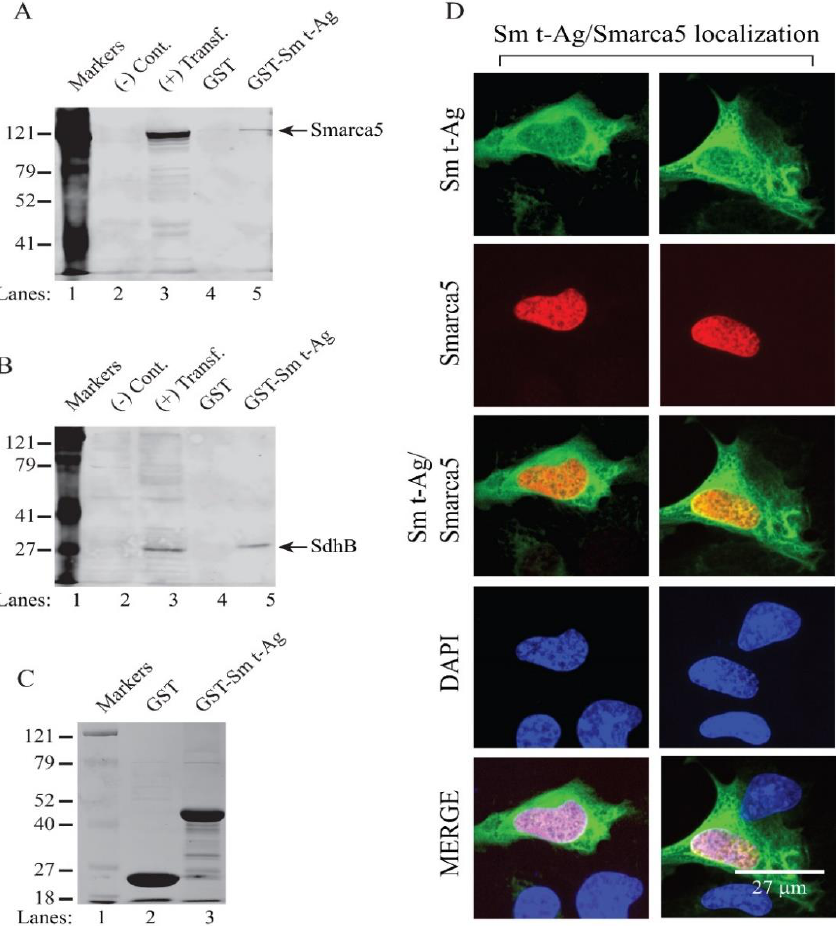
Figure 9. Validation of the JCV Sm t-Ag interaction with SDHB and Smarca5. ( A , B ) Analysis of the interaction of JCV Sm t-Ag with Smarca5 ( A ) and that of SDHB ( B ) by GST pull-down assays was carried out, as described in Materials and Methods. Whole-cell extracts (0.5 mg) prepared from HEK293T cells transfected with the FLAG-tagged Smarca5 expression plasmid (lanes 3 and 5) were incubated with either GST (2 µg) alone (lane 4) or GST-JCV LT-Ag (2 µg) (lane 5). After washing, proteins interacting with GST or GST-JCV Sm t-Ag were analyzed by Western blotting using an α-flag antibody for detection of flag-tagged Smarca5. ( B ) In parallel, similar GST pull-down experiments were carried out using whole-cell extracts prepared from HEK293T cells transfected with a FLAG-tagged-SDHB expression plasmid (lanes 4 and 5). In lanes 2 and 3 (A and B), whole-cell extracts from untransfected [(−) Cont.] and transfected cells [(+) transf.] were loaded as negative and positive controls, respectively. ( C ) Analysis of GST and GST-Sm t-Ag proteins by SDS-12% PAGE followed by coomassie blue staining, as described for Figure 8C. ( D ). Analysis of the subcellular distribution patterns of JCV Sm t-Ag and Smarca5 by ICC. SVG-A cells were co-transfected with both T7-tagged Sm t-Ag and FLAG-tagged Smarca5 expression plasmids and the subcellular localization of both proteins was analyzed by ICC, as described under Figure 8, using α-T7 polyclonal and α-FLAG monoclonal primary antibodies and FITC or rhodamine-conjugated secondary antibodies. Finally, microscopic images were obtained under a fluorescence microscope, as described under the Materials and Methods. Scale bar: 27 µm.